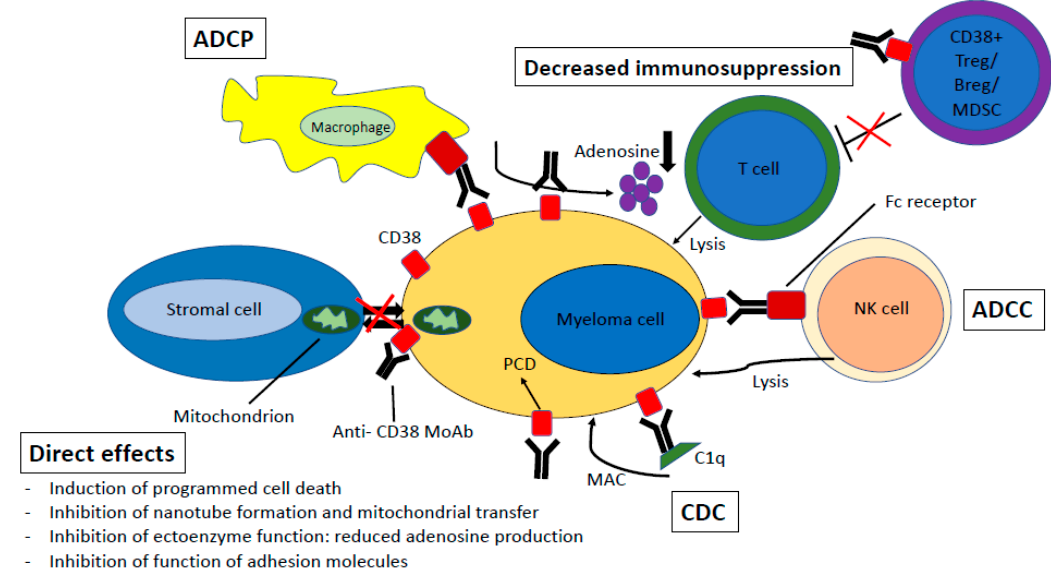
Figure 1. Mechanisms of action of CD38 − directed monoclonal antibodies. The figure displays a multiple myeloma cell expressing CD38, with the most important mechanisms of action of the CD38 − directed monoclonal antibodies. Abbreviations: ADCP: antibody-dependent cell-mediated phagocytosis; CDC: complement-dependent cytotoxicity; ADCC: antibody-dependent cell-mediated cytotoxicity; MoAb: monoclonal antibody; PCD: programmed cell death; MAC: membrane attack complex.